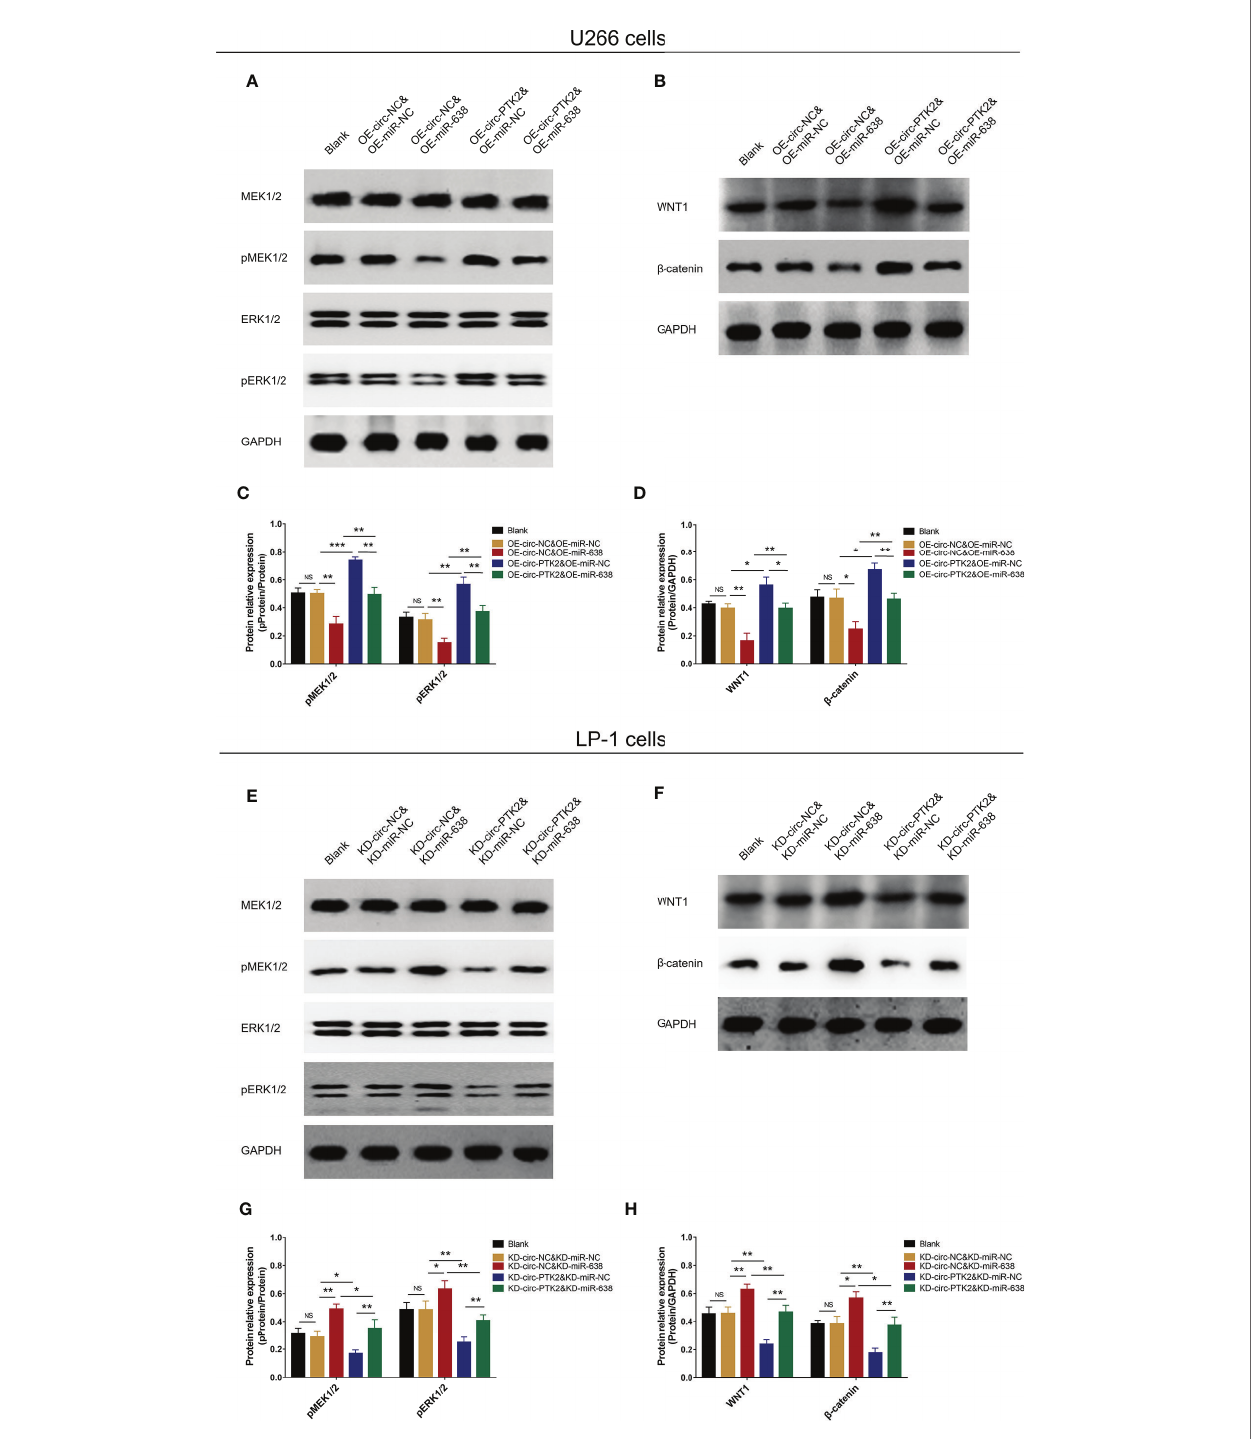
FIGURE 8 | Circ-PTK2 affected Wnt/ b -catenin and MEK/ERK signaling pathways via regulating miR-638. Comparison of pMEK1/2, pERK1/2, WNT1 and b -catenin protein expressions detected by western blot among different groups of U266 cells (A – D) . Comparison of pMEK1/2, pERK1/2, WNT1 and b -catenin protein expressions detected by western blot among different groups of LP-1 cells (E – H) . NS, non-signi fi cant; OE-circ-NC, circRNA control overexpression; OE-circ-PTK2, circ-PTK2 overexpression; KD-circ-NC, circRNA control knock-down; KD-circ-PTK2, circ-PTK2 knock-down; OE-miR-NC, miRNA control overexpression; OE-miR- 638, miR-638 overexpression; KD-miR-NC, miRNA control knock-down; KD-miR-638, miR-638 knock-down plasmid; * P < 0.05; ** P < 0.01; *** P < 0.001. Experiments were performed in triplicates. The comparison was determined by One-way ANOVA followed by Tukey ’ s multiple comparison